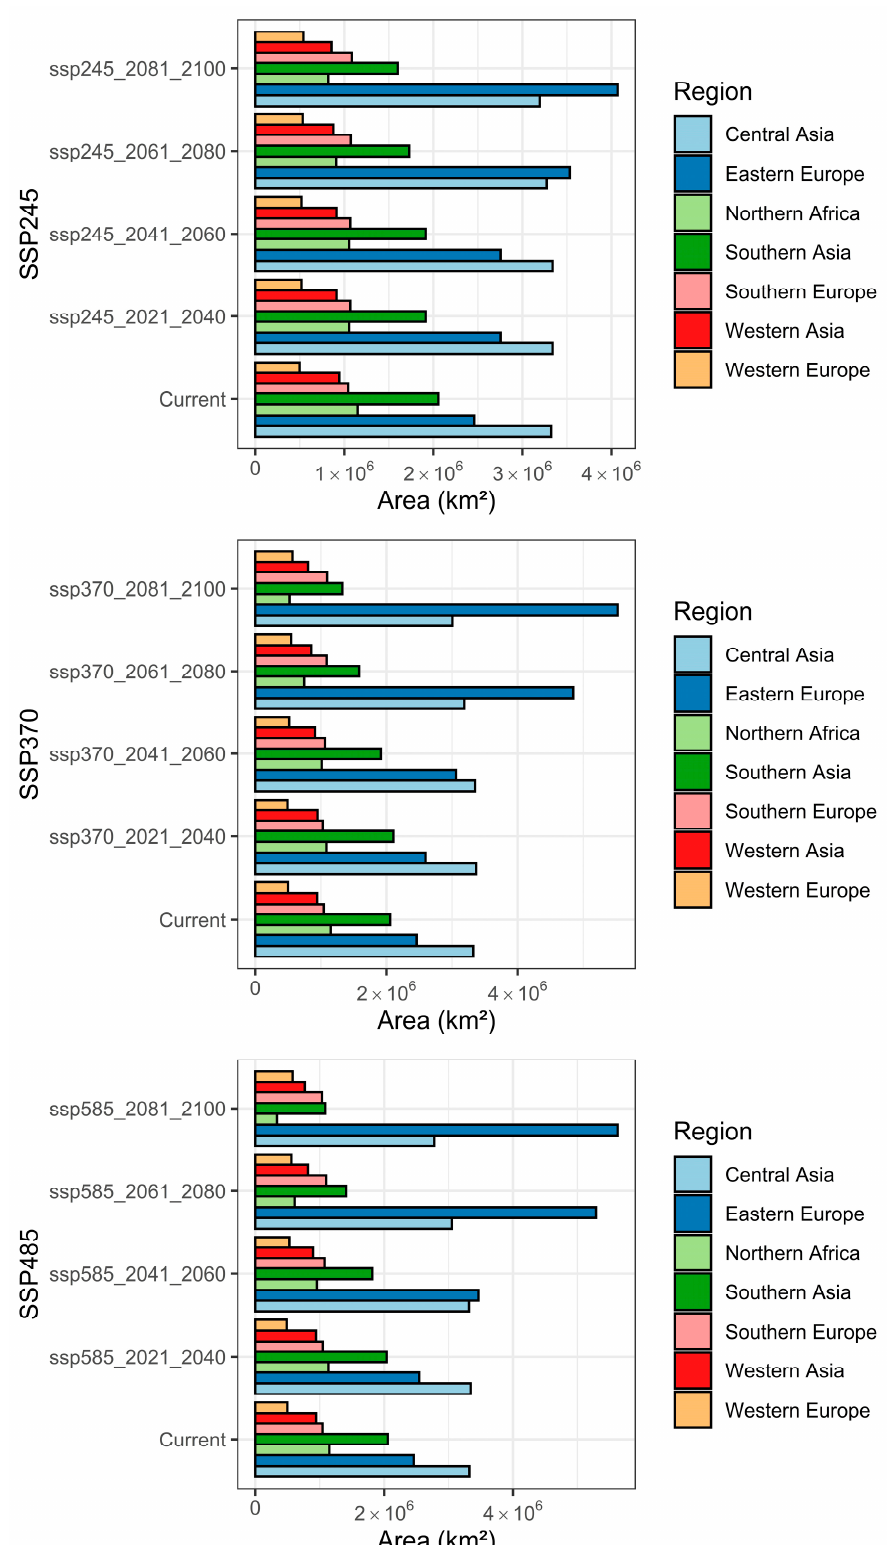
Figure A2. Change in the area of distribution of the species by region under different climate sce- narios.